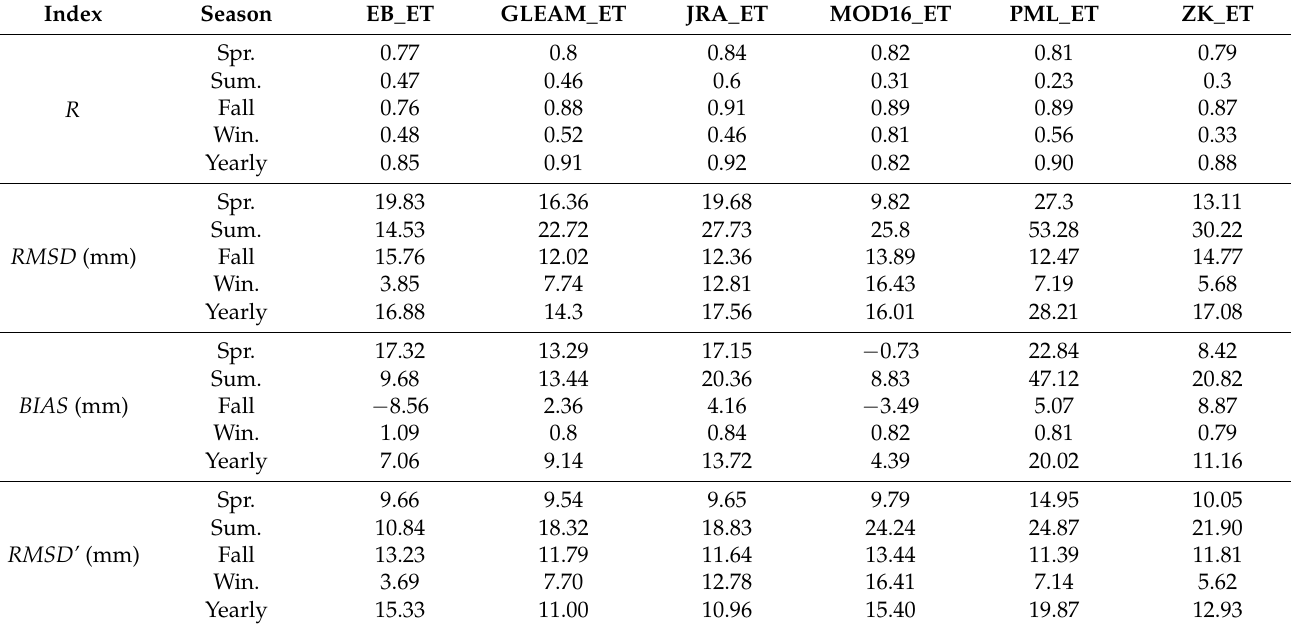
Table 3. Accuracy evaluation index values for the ET